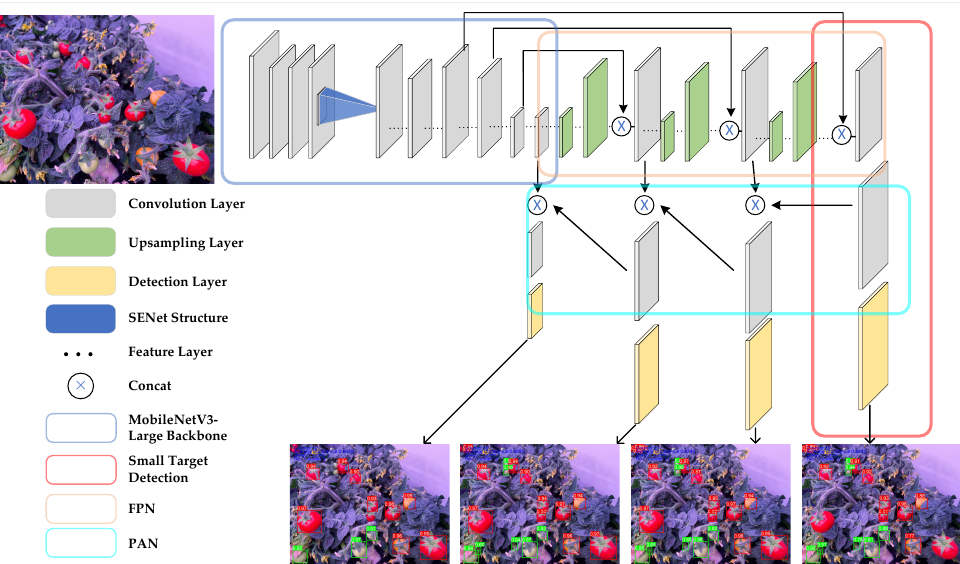
Figure 3. The integrated architecture of SM-YOLOv5 includes a backbone network (in blue) that was replaced with MobileNetv3-Large. The small-target detection layer added based on the original three-layer target detection model is represented by the red box. The FPN and PAN structures (in yellow and cyan boxes, respectively) were supplemented with a small object detection layer to enhance the detection of small targets.